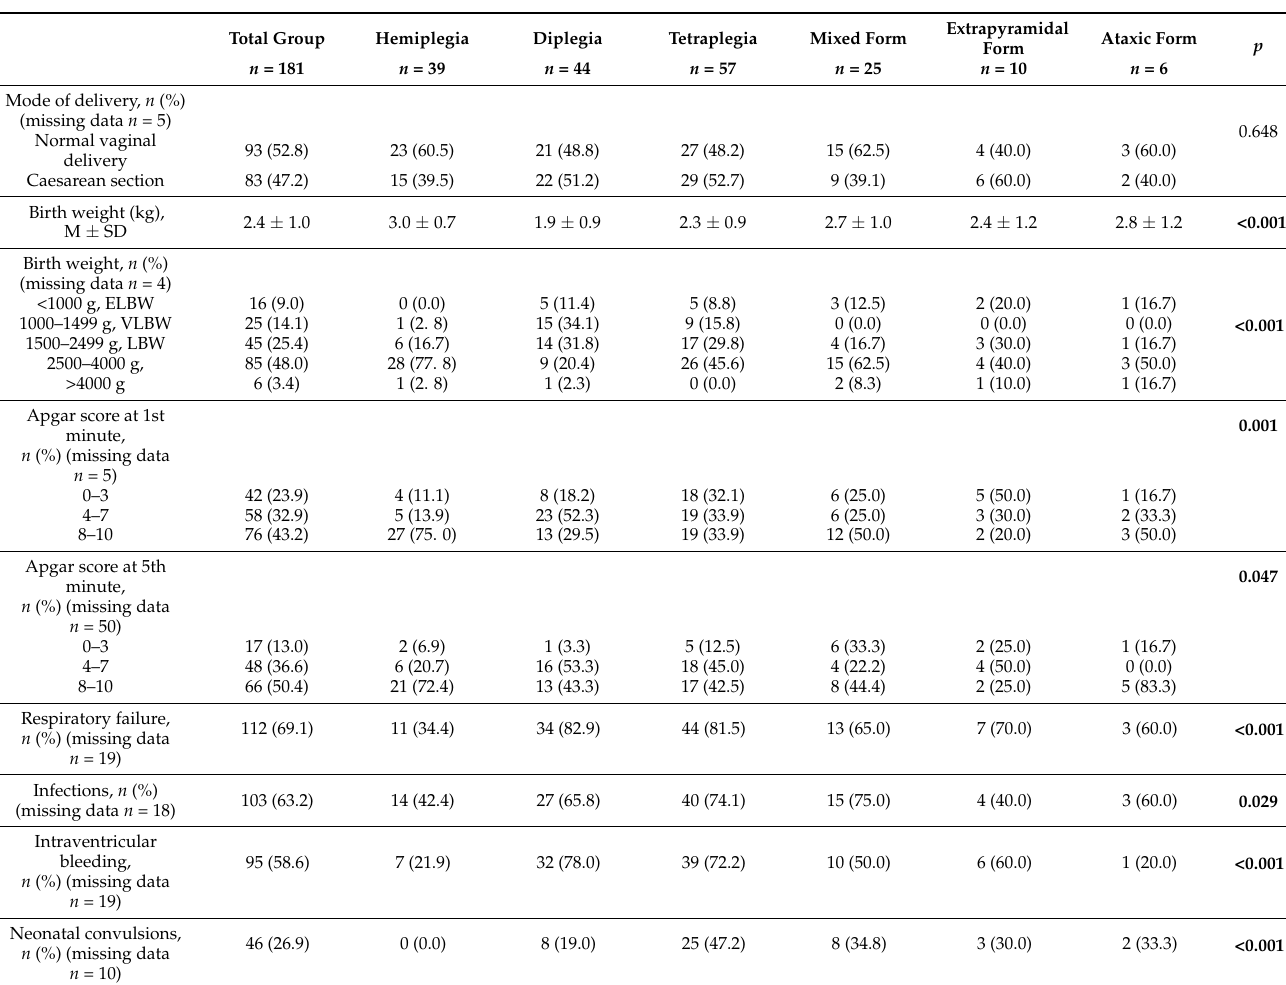
Table 3. Perinatal, neonatal, and infant-related risk factors in various types of CP. Total Group Diplegia Tetraplegia Mixed Form